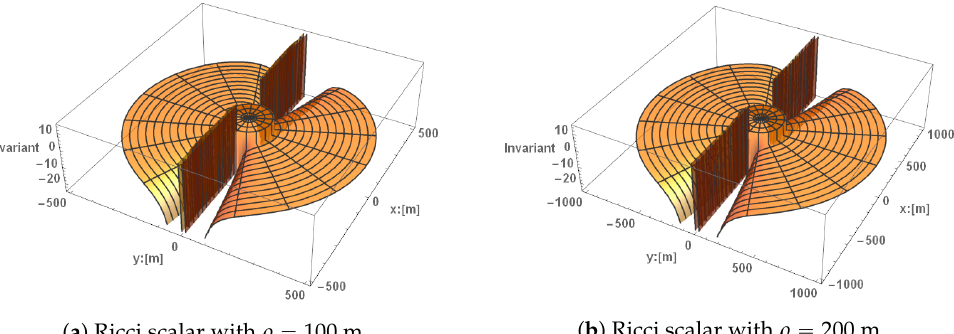
Figure 4. The warp bubble radius, ρ , for the Ricci Scalar R is plotted in the figures above. The other parameters were set to be σ “ 50,000 m ´ 1 , a “ 1.0 m s ´ 2 , and t “ 1 s. The plots were rendered using Mathematica’s ® RevolutionPlot3D. It plots a function by rotating the function around the z-axis. The amount that the space diverges from being flat is represented by the invariant function’s magnitude, and its amount is labeled on the vertical axis. The x and y-axis are displayed on the plots, and they display the distance from a spaceship in the flat portion at the center of each figure. Each radial line in the left hand column corresponds to a distance of approximately 33 m and each radial line in the right hand column corresponds to a distance of approximately 67 m. The constant portion to the right of the harbor is to the front of the warp bubble, and the constant portion to the left of the harbor is the back of the warp